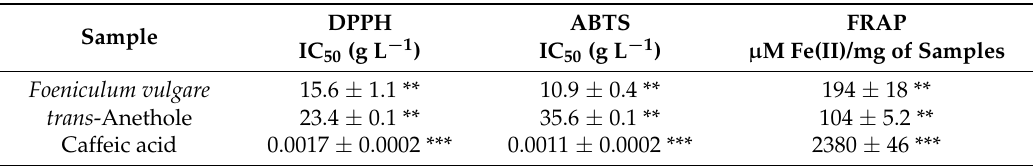
Table 2. Antioxidant activity of the essential oil Foeniculum vulgare as determined by the ABTS, DPPH, and FRAP assays